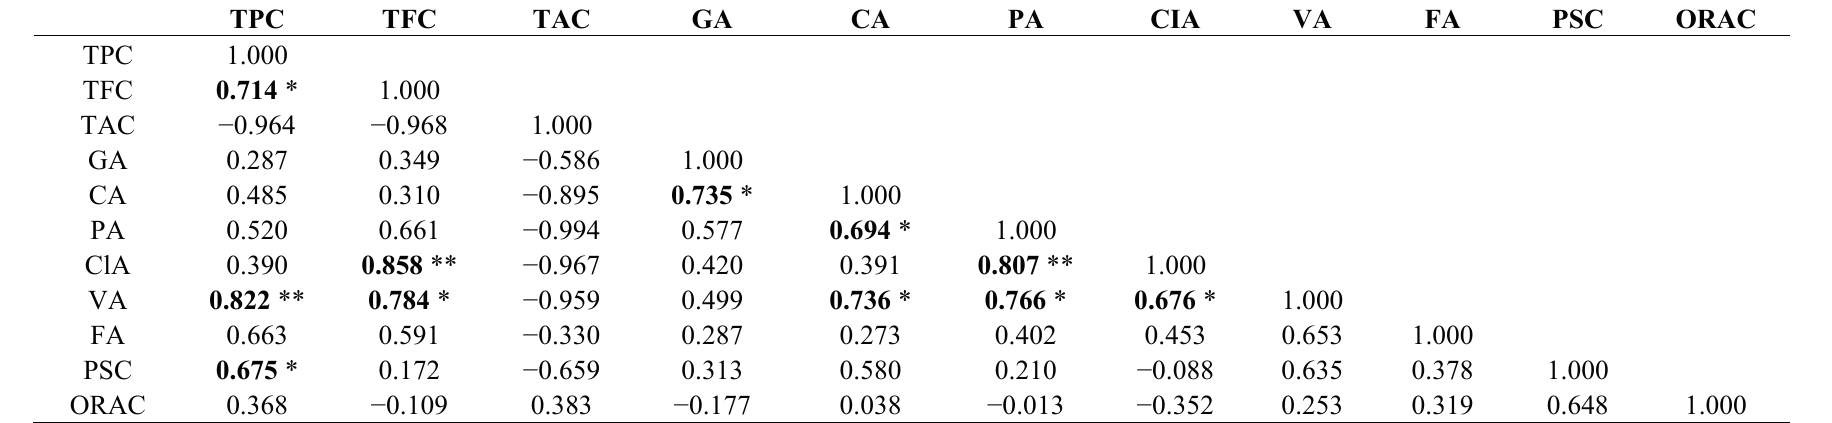
Table 5. Correlation coefficient matrix between phenolics content and antioxidant properties in mango pulp.